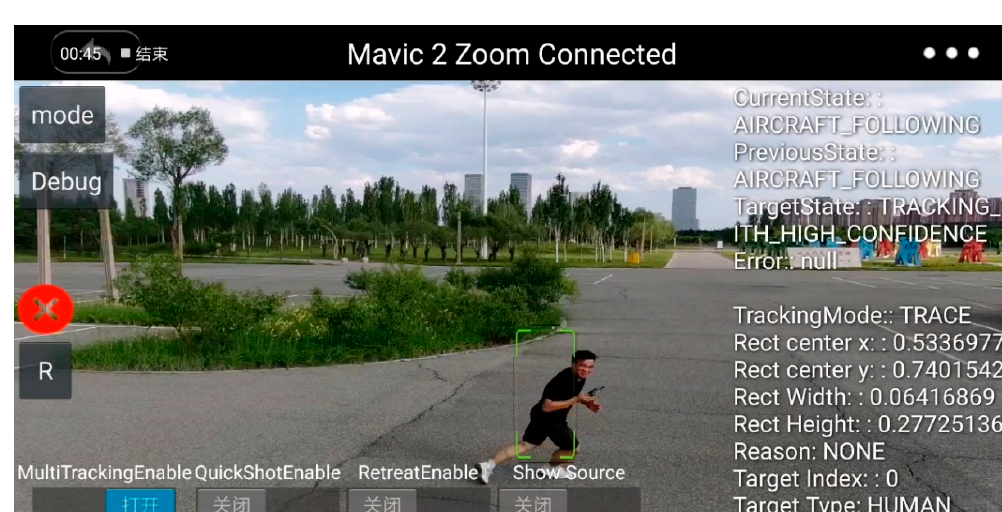
Figure 15. Snapshot of the IARC 2018 [33].